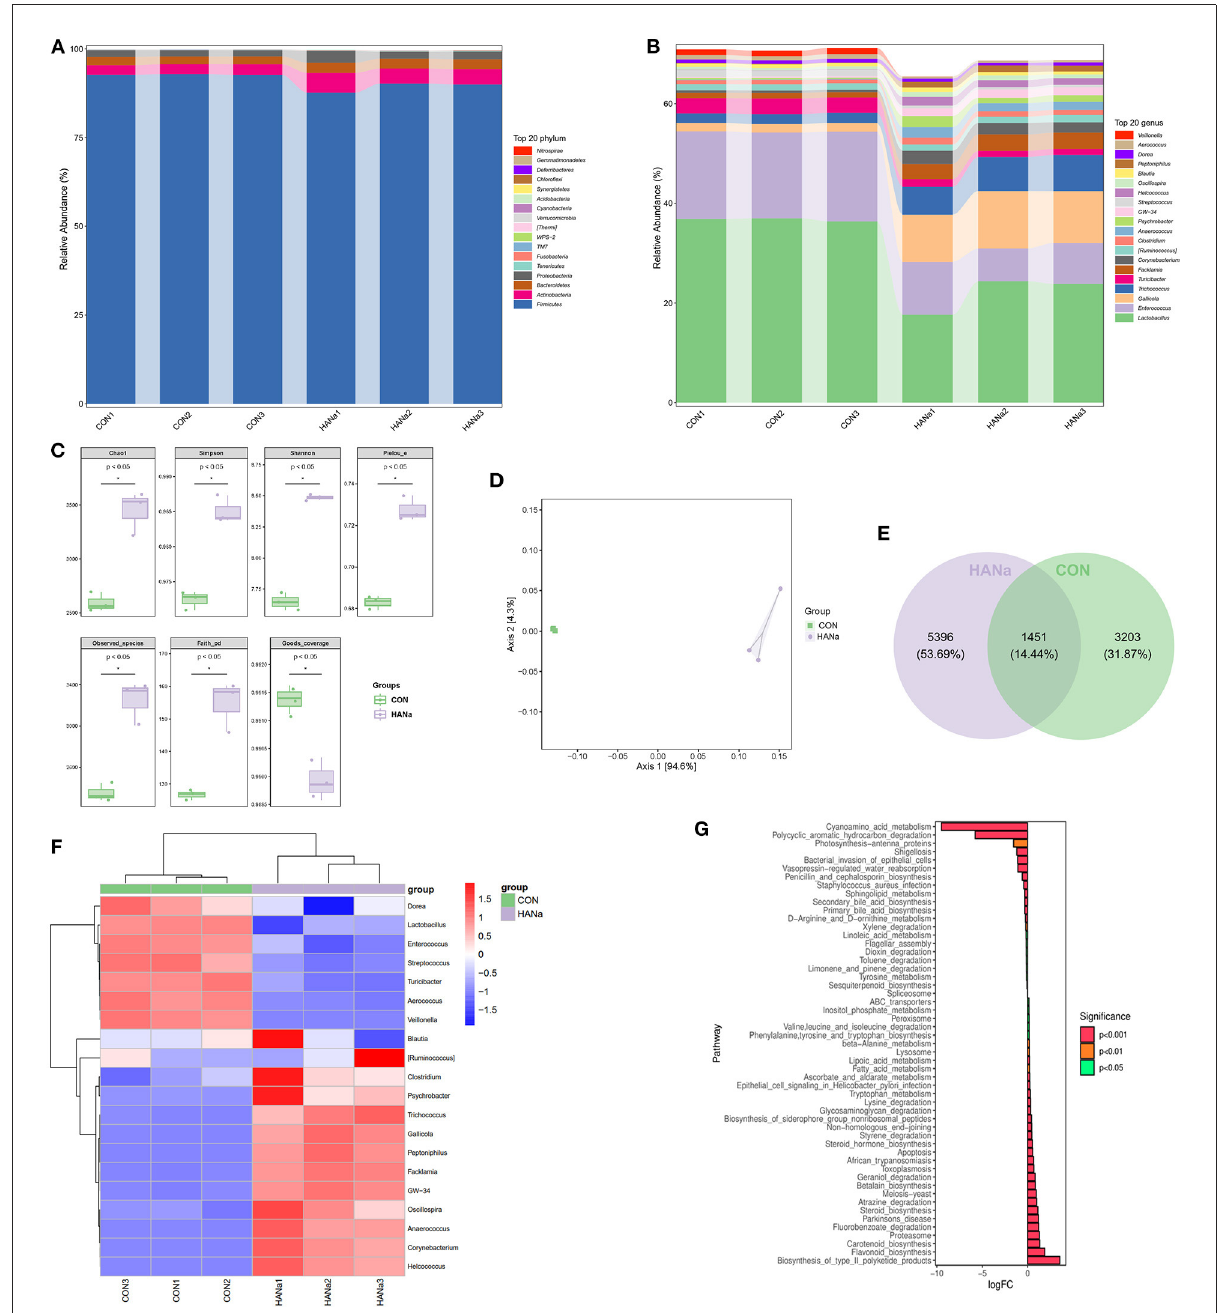
FIGURE1 Effect of sodium humate on alterations in the intestinal microbiome structure of aged laying hens. (A) Composition of the top 20 phyla. (B) Composition of the top 20 genera. (C) Alpha diversity analysis of intestinal microbiomes. (D) Principal coordinates analysis (PCoA) of intestinal microbiome structures. (E) Venn diagram displaying the overlaps among groups. (F) Genus-level species composition heat map based on intestinal microbiome colony biclustering. (G) KEGG metabolic pathway